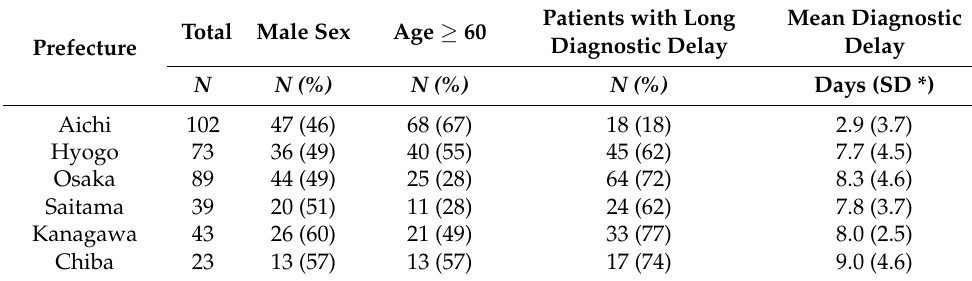
Table 1. Demographic data and diagnostic delay in COVID-19 patients with symptom onset between 24 February and 15 March (from the 9th to the 11th week) by prefecture.